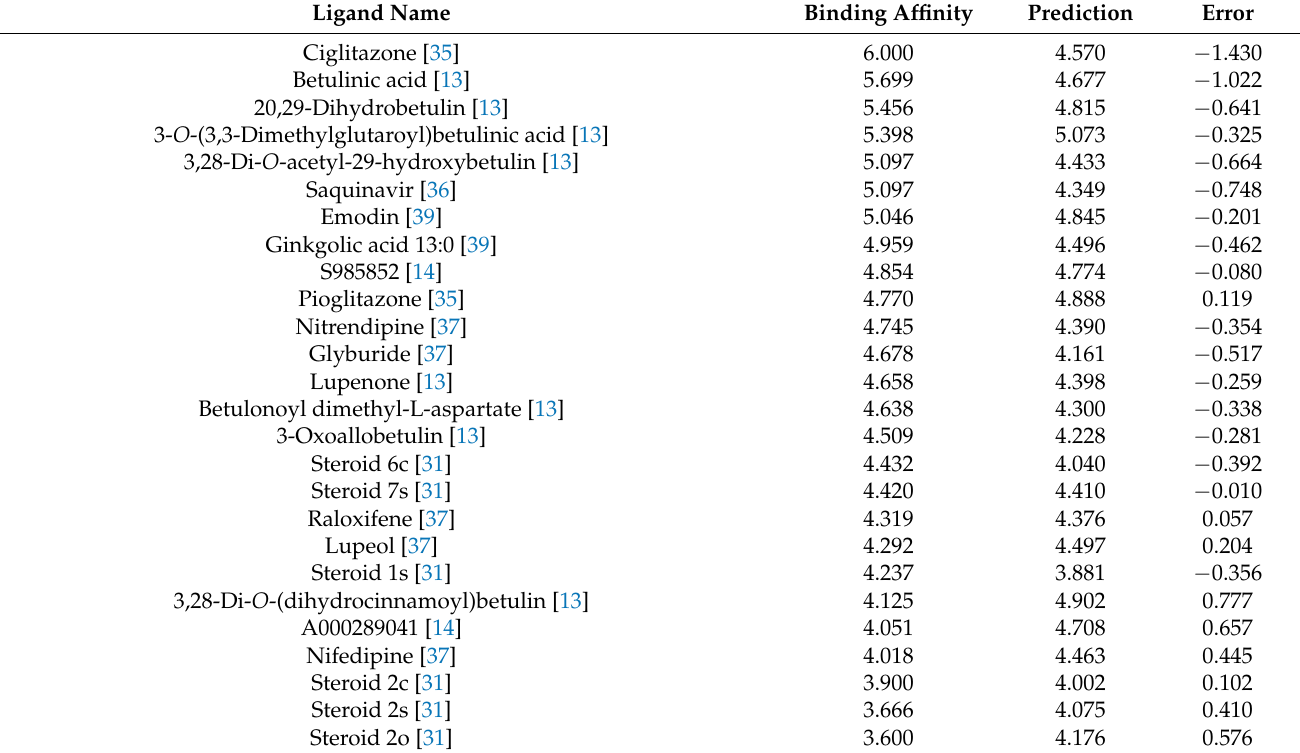
Table 4. Test set to validate the atom-based QSAR model for anti-preS1 activity. Listed are experimentally determined binding affinities ( − log (IC 50 M)) of ligands and predicted binding affinity by the resulting QSAR model. Error describes the difference between the experimentally determined and the predicted binding affinity. Previous descriptions of the compounds as NTCP inhibitors are referenced. As an exception, the arylmethylamino “steroid” compounds are introduced here as novel NTCP inhibitors for the first